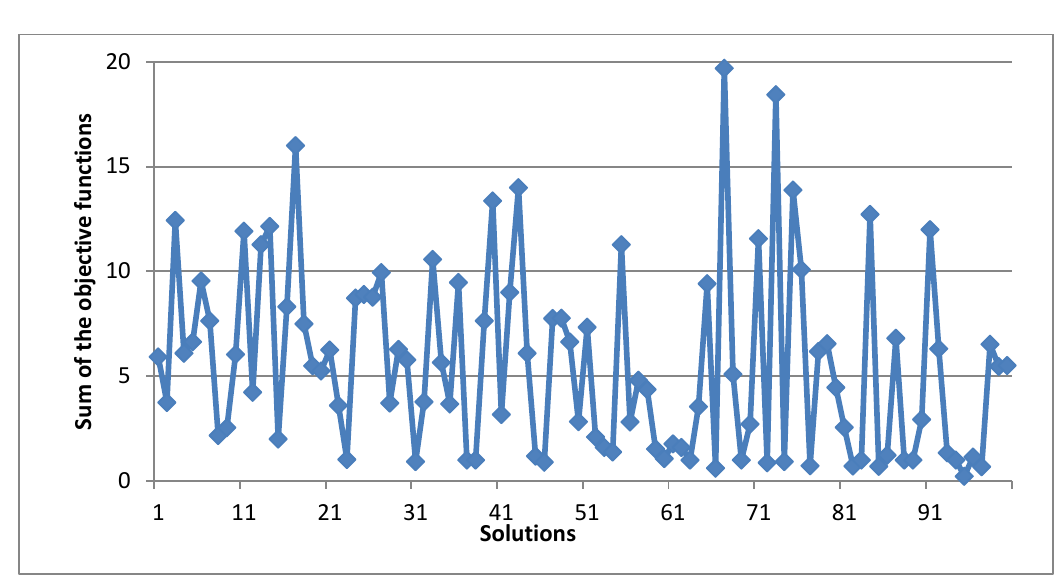
Figure 10. Summation of objective functions absolute values so obtained for all nondominated solutions corresponds to hydrocarbon combustion problem